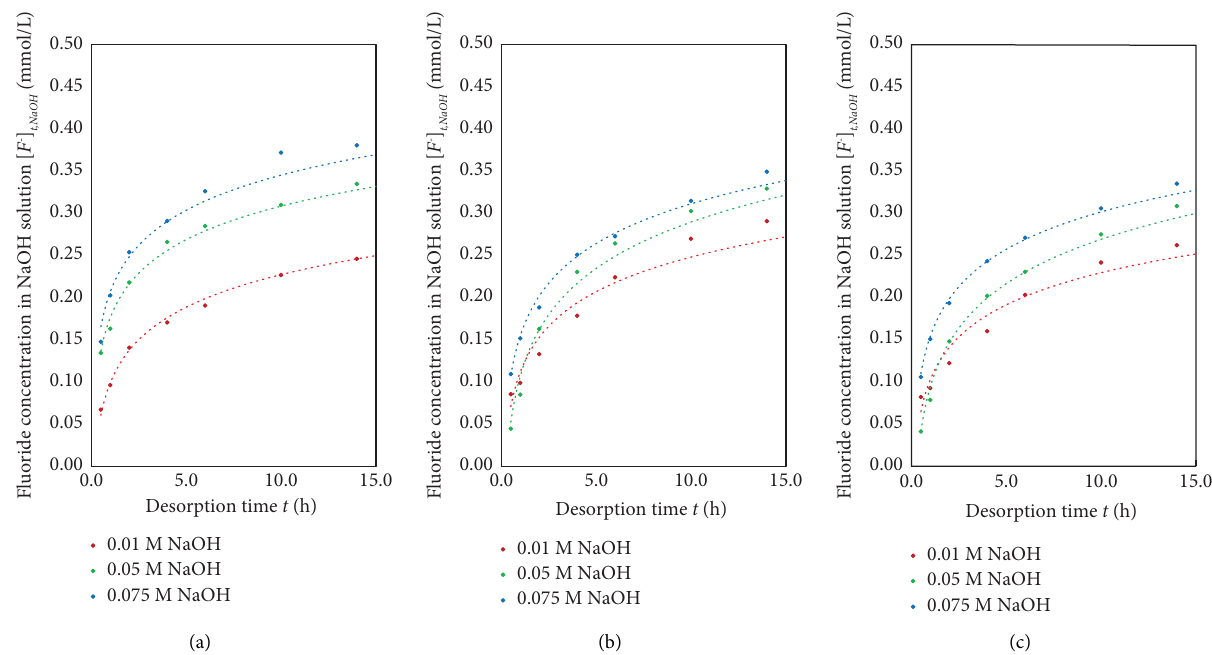
Figure 2: Fluoride desorption kinetics of bone char using NaOH solution at pH 7 and 30 ° C. (a) 1 st regeneration. (b) 5 th regeneration. (c) 10 th